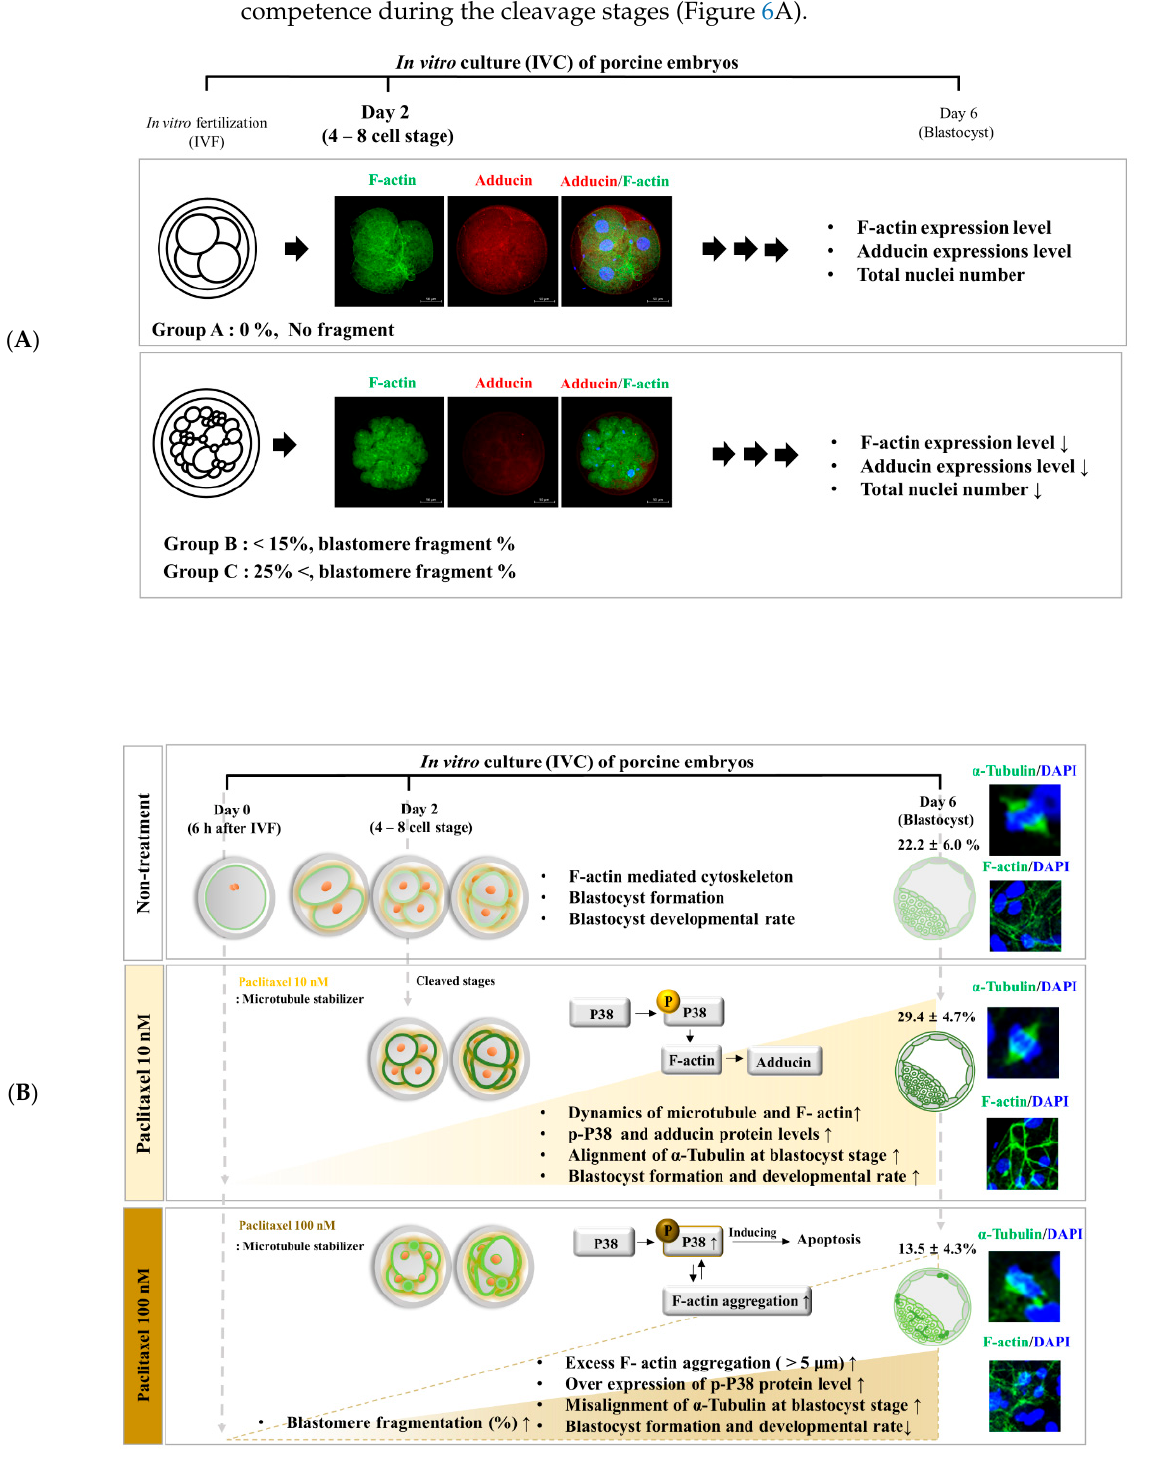
Figure 6. Graphical summary. Schematic diagram illustrating the correlation between F-actin/adducin cytoskeleton morphology and blastomere fragment rate related to porcine embryo quality during early embryonic development stages. ( A ): Top panel); Em- bryos with blastomere fragment significantly decreased the developmental competence until